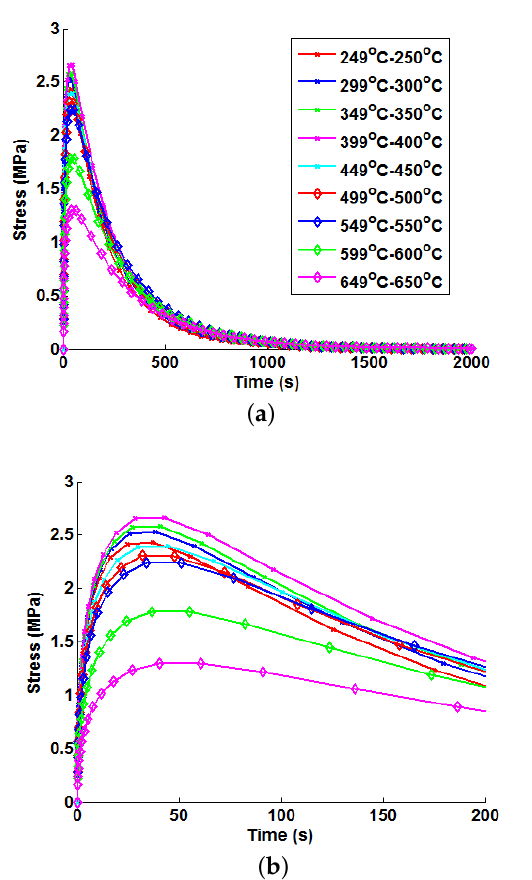
Figure 7. Variations in thermal stress responses due to unit step bulk steam temperature increments, showing: ( a ) general development and decay behaviour; and ( b ) magnified thermal stress development